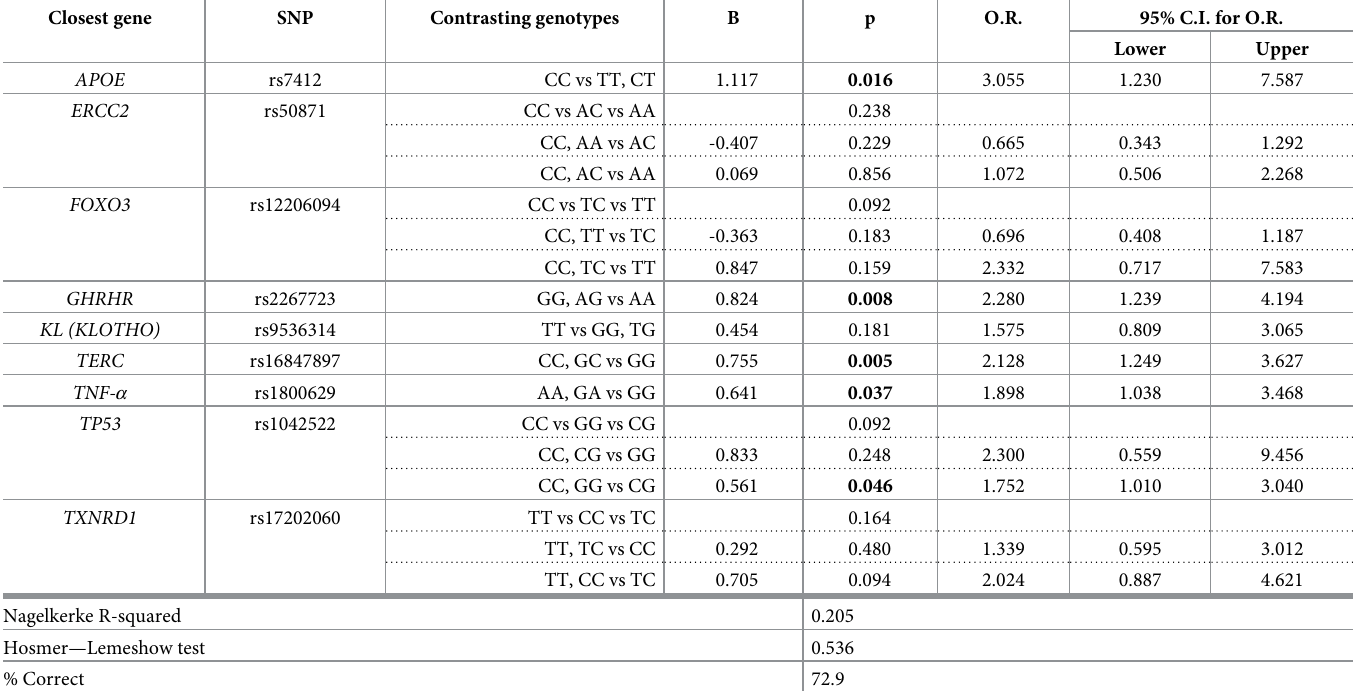
This table shows all the SNPs that together make up the best model for predicting survival to age 90+, the genotypes that were contrasted within the model, beta values, odd ratios and 95% confidence intervals. The p-values of SNPs that passed the significance threshold of p � 0.05 are highlighted in bold. Nagelkerke R-squared value, indicating the amount of variance explained by the model, is shown at the bottom of the table along with the results of Hosmer—Lemeshow test and the percentage of correctly classified